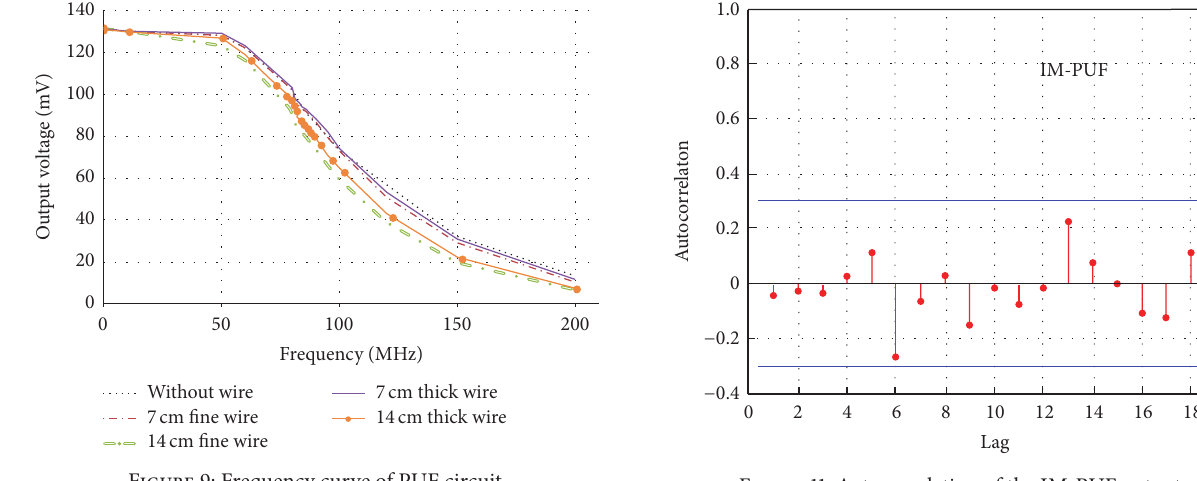
Figure 11: Autocorrelation of the IM-PUF output.